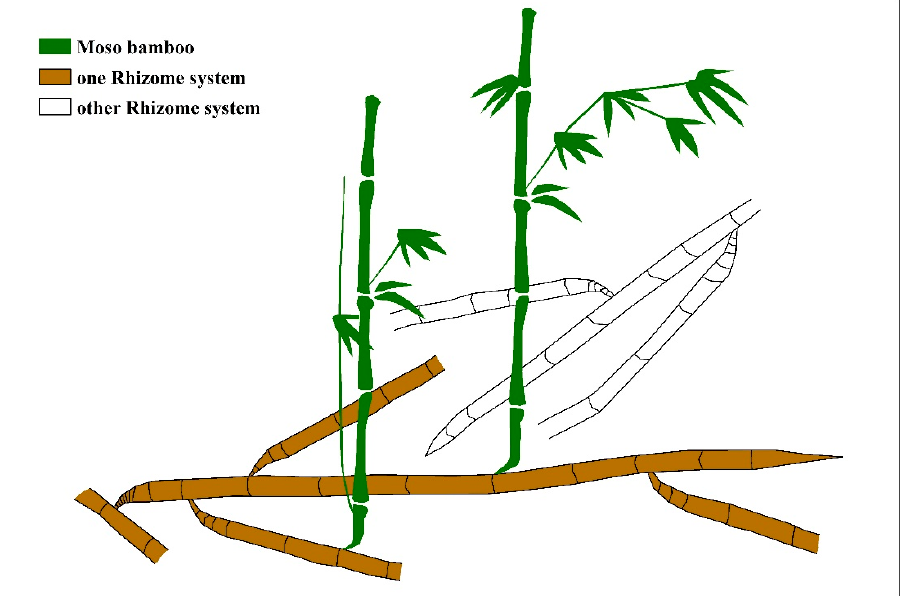
Figure 1. Diagram illustrating the generalised spatial distribution of moso bamboo rhizomes. The rhizome system is composed of interconnected branches emanating from the same parent bamboo plant.